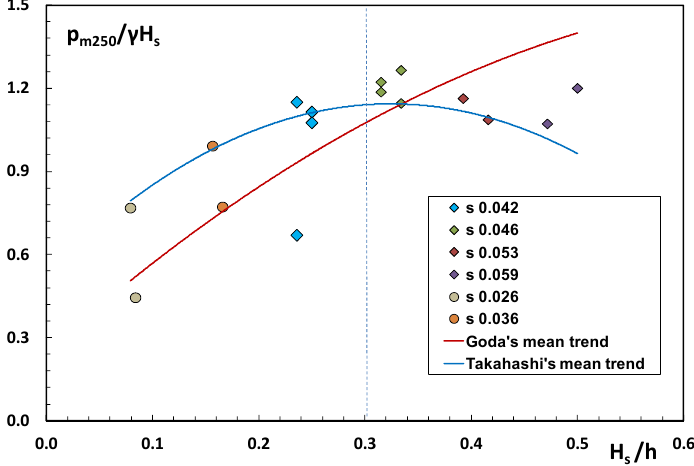
Figure 15. Non dimensional values of the mean pressure as function of the wave height to depth